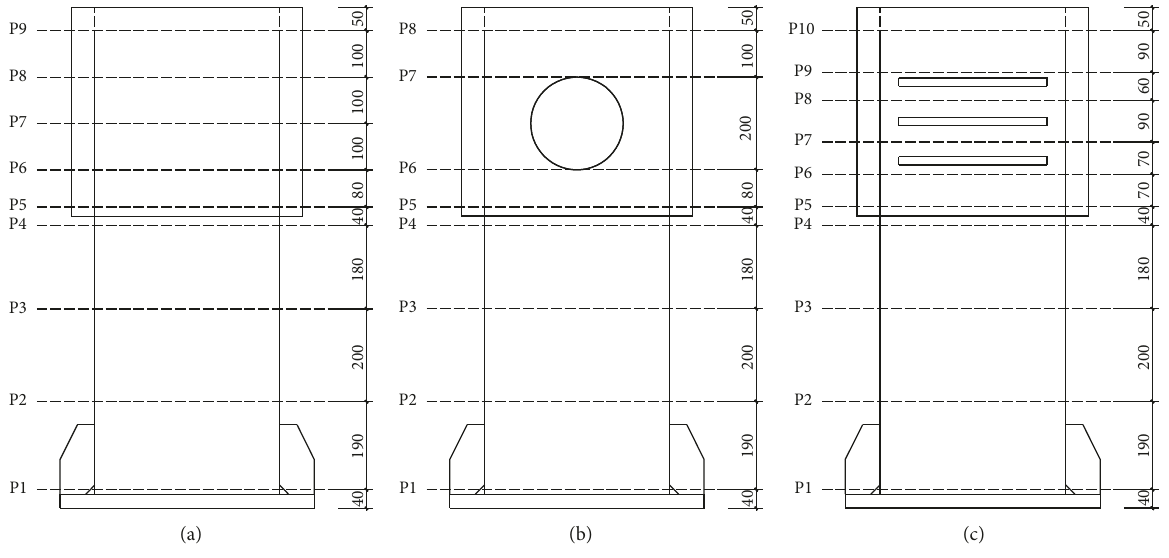
Figure 16: Different cross section along the height of the specimen: (a) SJ1-1/SJ1-2, (b) SJ1-3, (c) Table 4: The results of composite action.